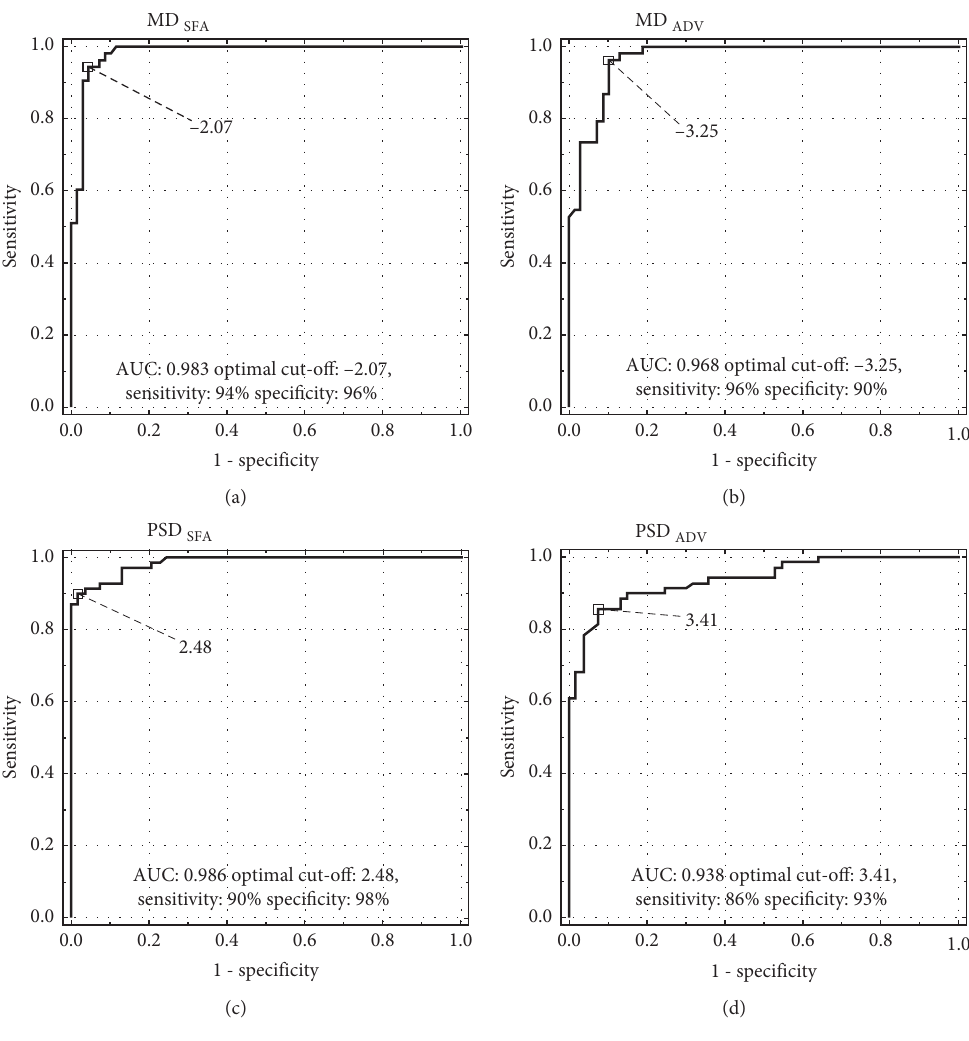
Figure 9: Receiver operating characteristic curves for MD (a, b) and PSD (c, d).